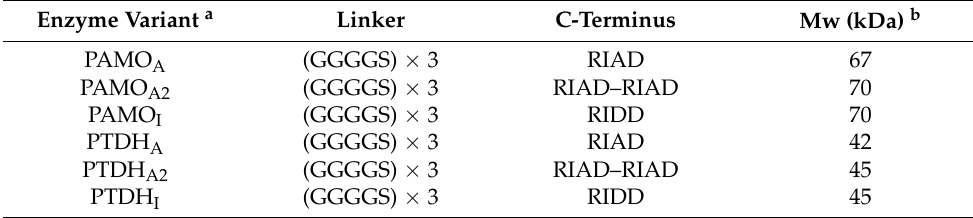
Table 1. Tagged enzyme